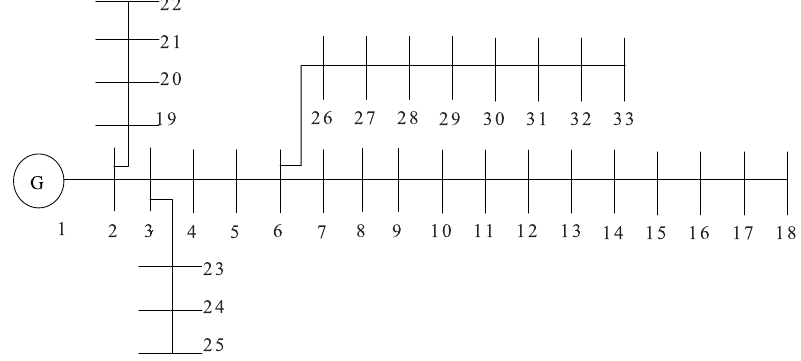
Figure 9. Line diagram of the 33 bus